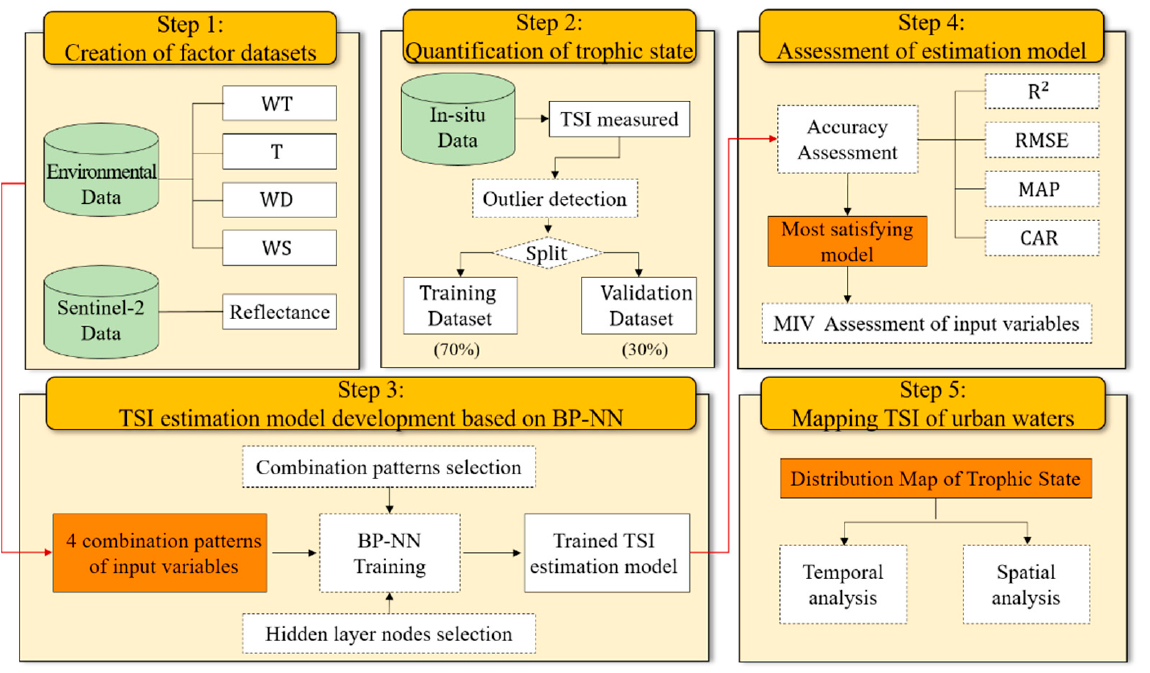
Figure 2. Framework of the trophic state index (TSI) estimation model developed in this study.